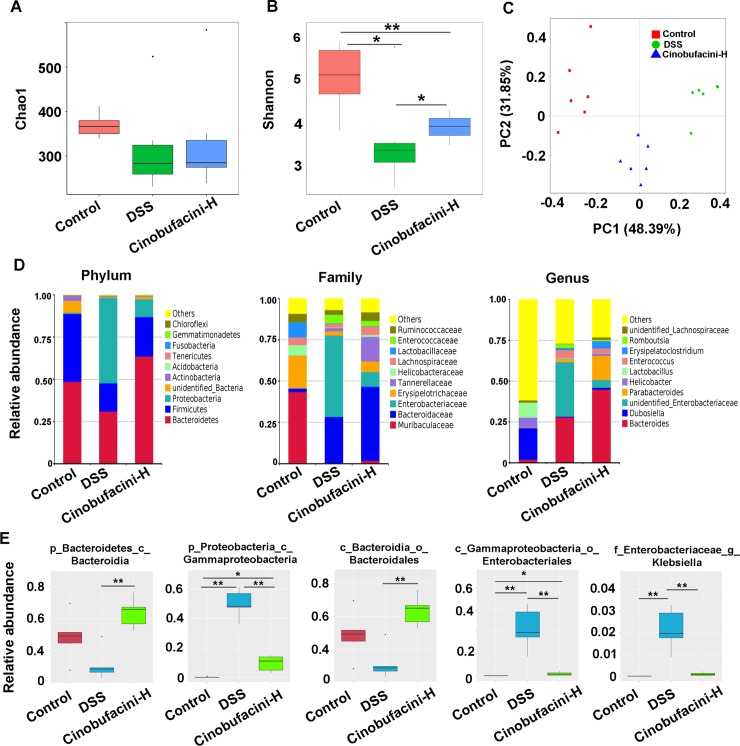
The effect of cinobufacini on the composition of intestinal bacteria in DSS-induced mice.(A, B) Alpha diversity indices boxplot, including Chao1 and Shannon. (C) PCoA biplot based on the weighted UniFrac distances. (D) The relative abundance of gut microbiota at phylum, family, and genus levels. (E) MetaStat analysis showing the bacterial abundance significantly reversed by cinobufacini across the different groups. k, kingdom; p, phylum; c, class; o, order; f, family; g, genus. The dose of cinobufacini was 30.0 mg/kg body weight. All values are mean ± SD (n = 6 mice/group). * p <0.05; ** p <0.01.